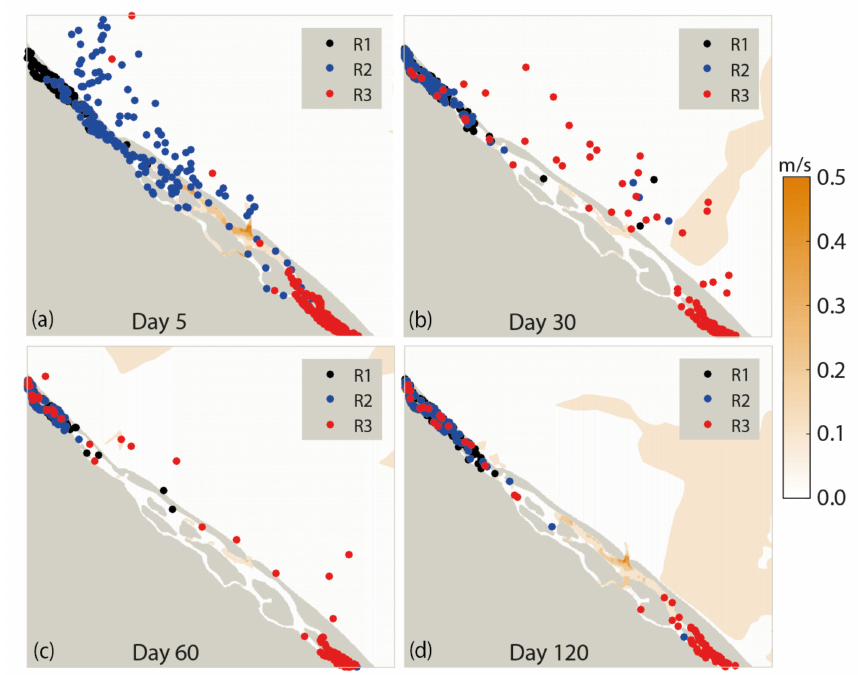
Figure 9. Spatial distributions of the current speed and trajectories for particles released at R1, R2 and R3 (please refer Figure 2 for initial release locations) on ( a ) Day 5, ( b ) Day 30, ( c ) Day 60 and ( d ) Day 120 during the southwest monsoon for new inlet